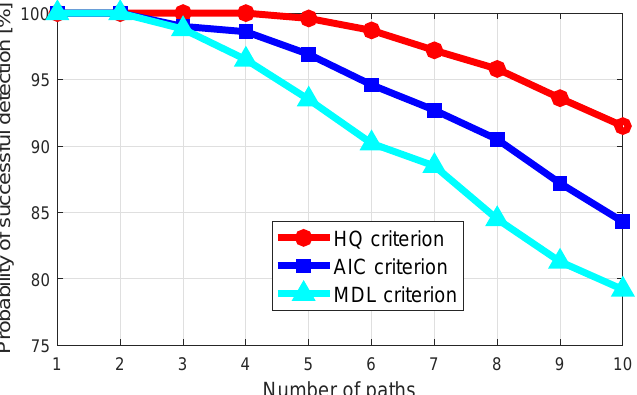
Figure 10. Comparison of the probability of successful detection regarding the number of paths with different information theory